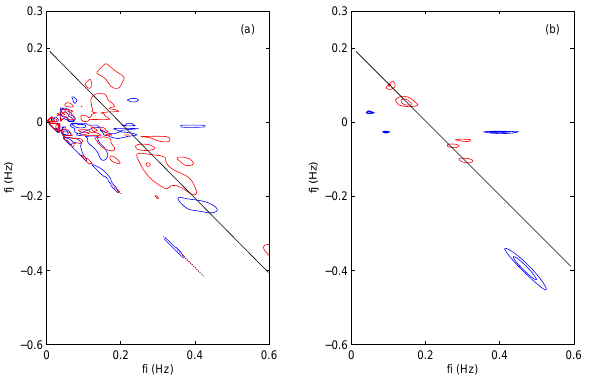
Fig. 9. Contours of (a) the wavelet bicoherence b 2 uuu (contour lev- els: 0.45 and 0.8) and (b) the wavelet bispectrum B uuu (contour lev- els: 0.4 and 0.6 times of the maximum value in stage I with extreme values at low frequencies eliminated) in stage I (blue contours) and stage II (red